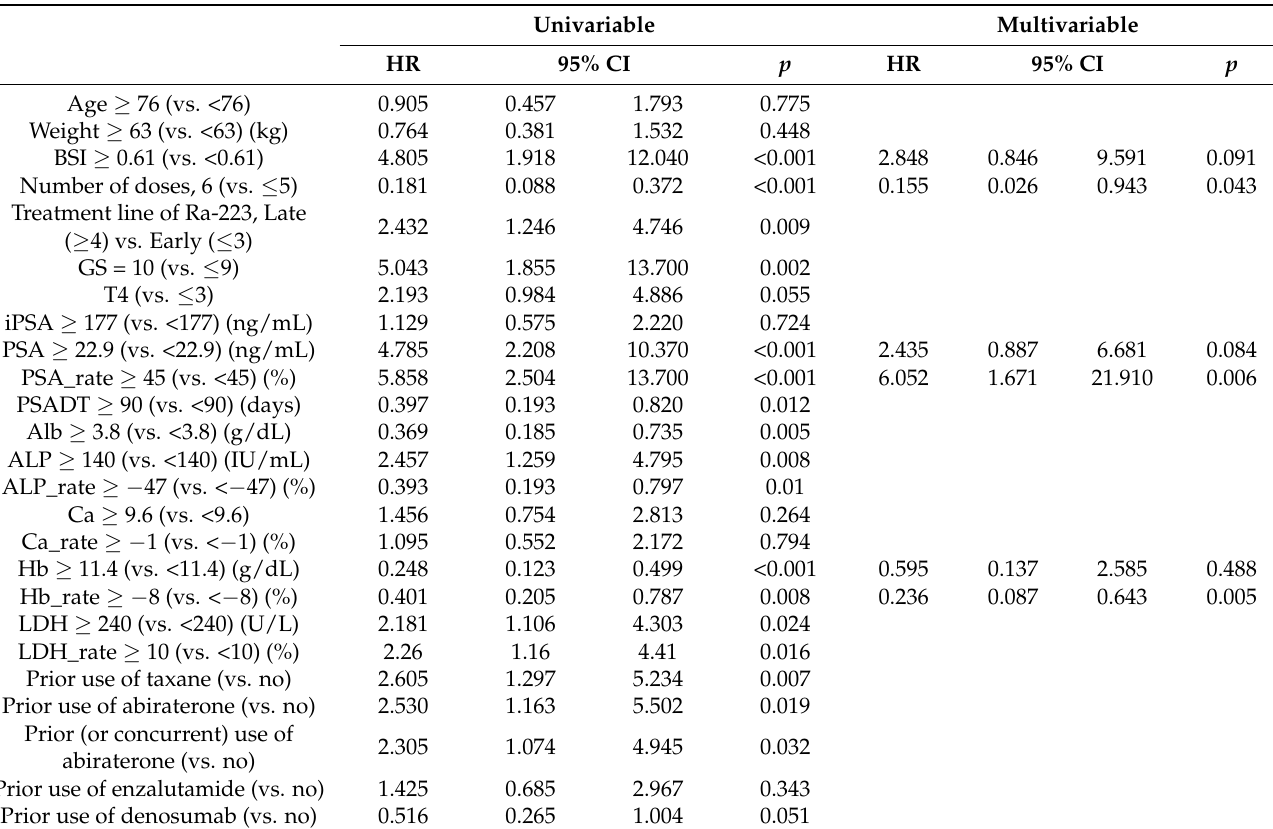
Table 2. Result of Cox proportional hazards analysis for OS. Univariable